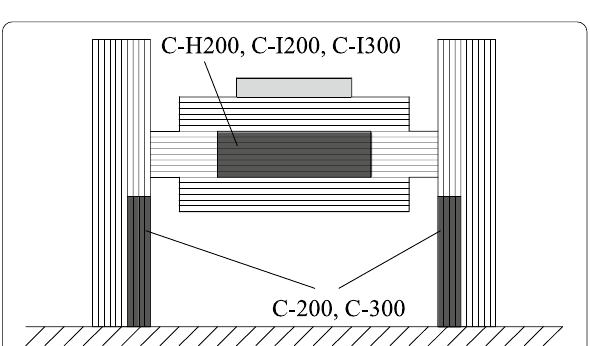
Fig. 9 Schematic diagram of the compression specimen sampling location perpendicular to the